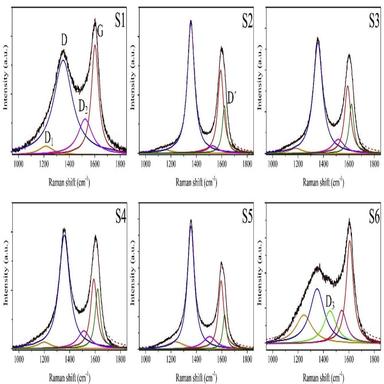
Deconvoluted Raman spectra from S1 to S6 in the range of 1000 cm1 to 1850 cm1 : D1-band (~1200 cm1 ) related to the influence of C-sp3 hybridization, D band (~1350 cm1 ) which correspond to the defect formation, D2-band (~1510 cm1 ) linked with the CeH bonds, D3-band (~1450 cm1 ) linked with the CeOH bonds effect over the surface, G band (~1590 cm1 ) represent the C]C bonds in-plane vibration and the dispersive vibration mode D0 -band (~1620 cm1 ). (A colour version of this figure can be viewed online.)